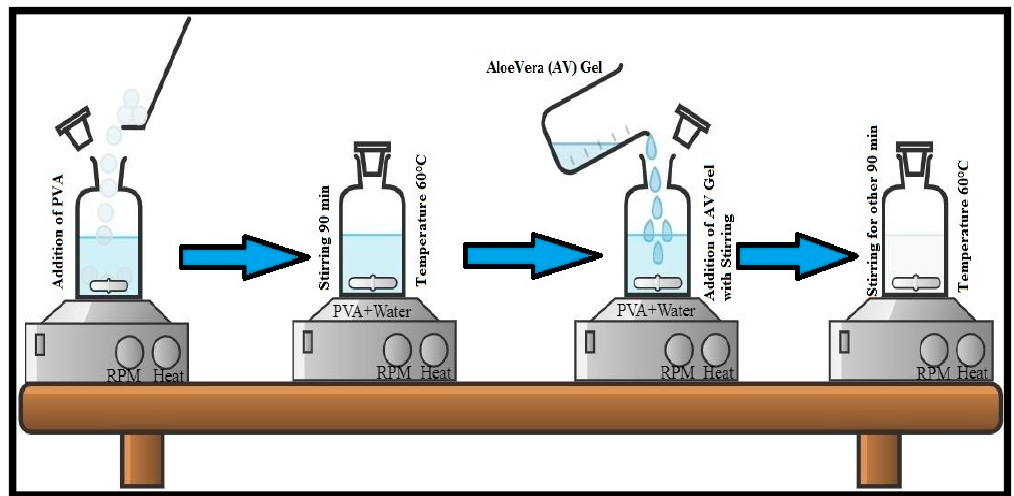
Figure 1. Flow diagram of Aloe Vera and Polyvinyl Alcohol (AV / PVA) solution formation process.